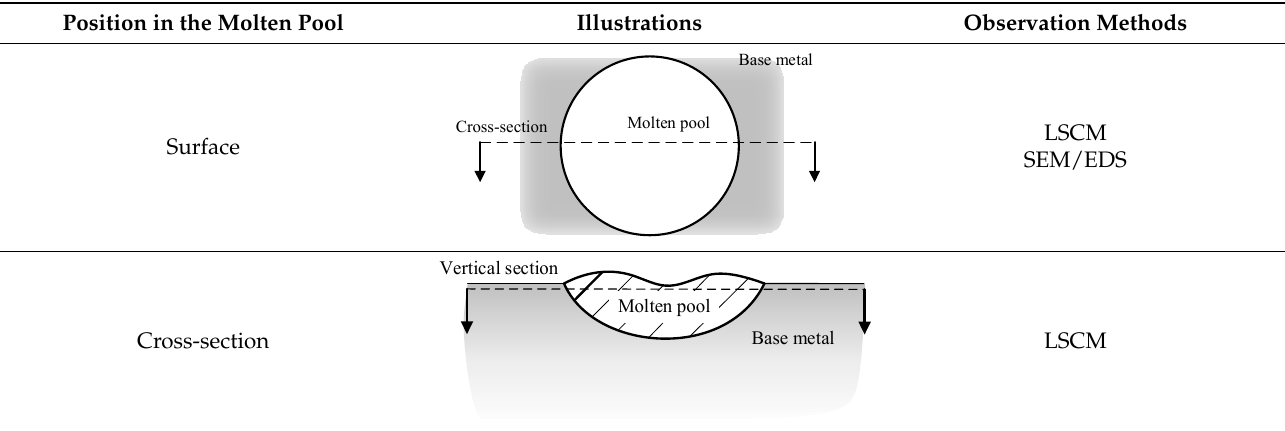
Table 2. Schematic of the detection methods used in different detection positions. Position in the Molten Pool